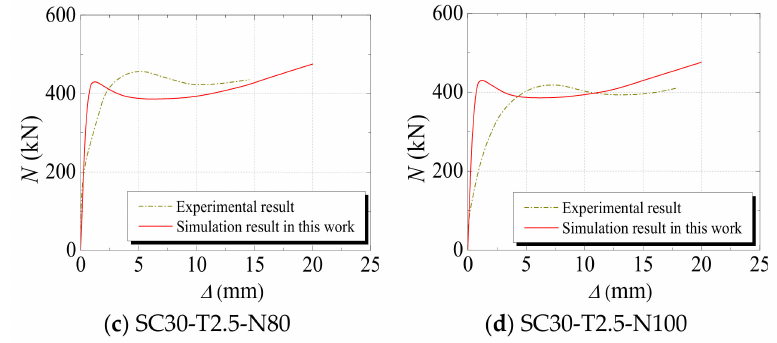
Figure 7. Comparisons between the numerical results in this study and the experimental results in [36].